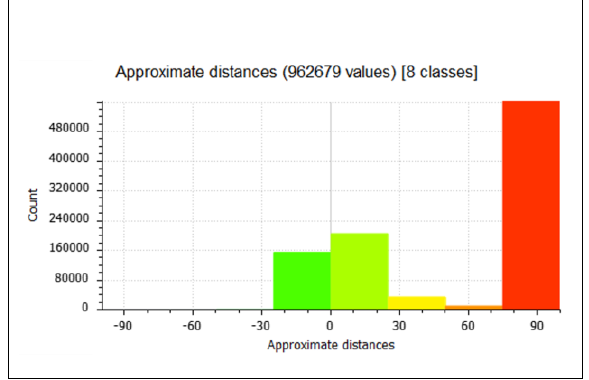
Figure 12. Histogram generated by CloudCompare software showing the classes of the deviation values between the point cloud model and the NURBS